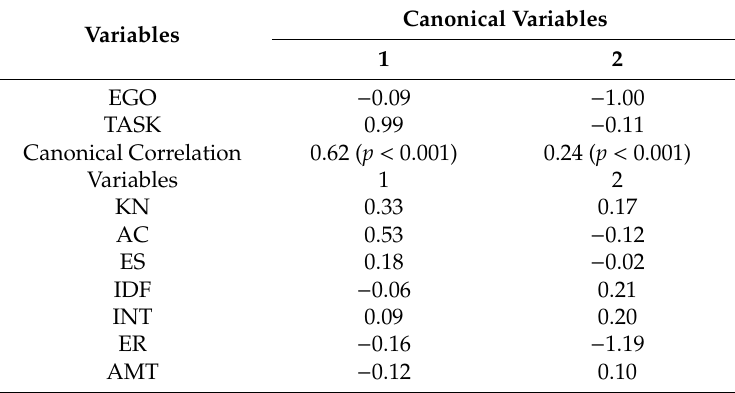
Table 4. Weighs for canonical